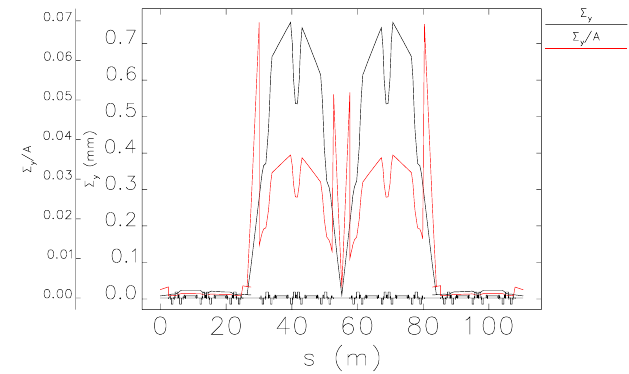
FIG. 5. (Color) Projected rms vertical beam size for the APS with h (cid:3) 1 and V (cid:3) 6 MV , along with the ratio of the beam size to the vertical